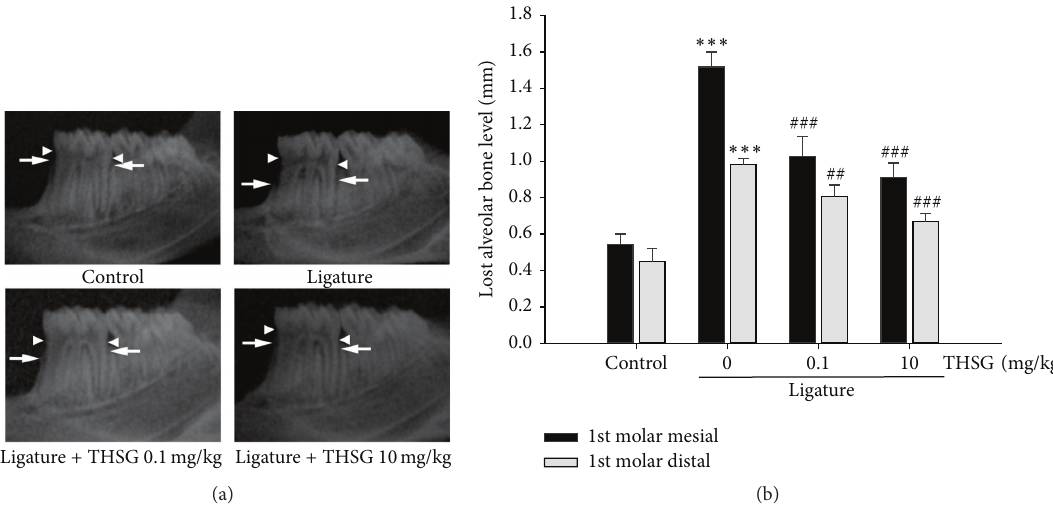
Figure 5: THSG attenuated ligature-induced experimental periodontitis. Rats were performed ligature-induced experimental periodontitis at first molar and fed with THSG (0.1 or 10mg/kg/day dissolved in sterile water) or sterile water by gavage for 7 days. (a) The alveolar bone crest (white arrow) and the cementoenamel junction (CEJ, white arrowhead) were shown on radiographic images of the mandible from these treatments. (b) The radiographic lost alveolar bone level was measured along the mesial/distal root surface and was defined as the distance from the CEJ to the most coronal level of the alveolar bone crest. ( ∗∗∗ 𝑝 < 0.001 was compared with control group. ## 𝑝 < 0.01 ; ### 𝑝 < 0.001 were compared with 0mg/kg THSG